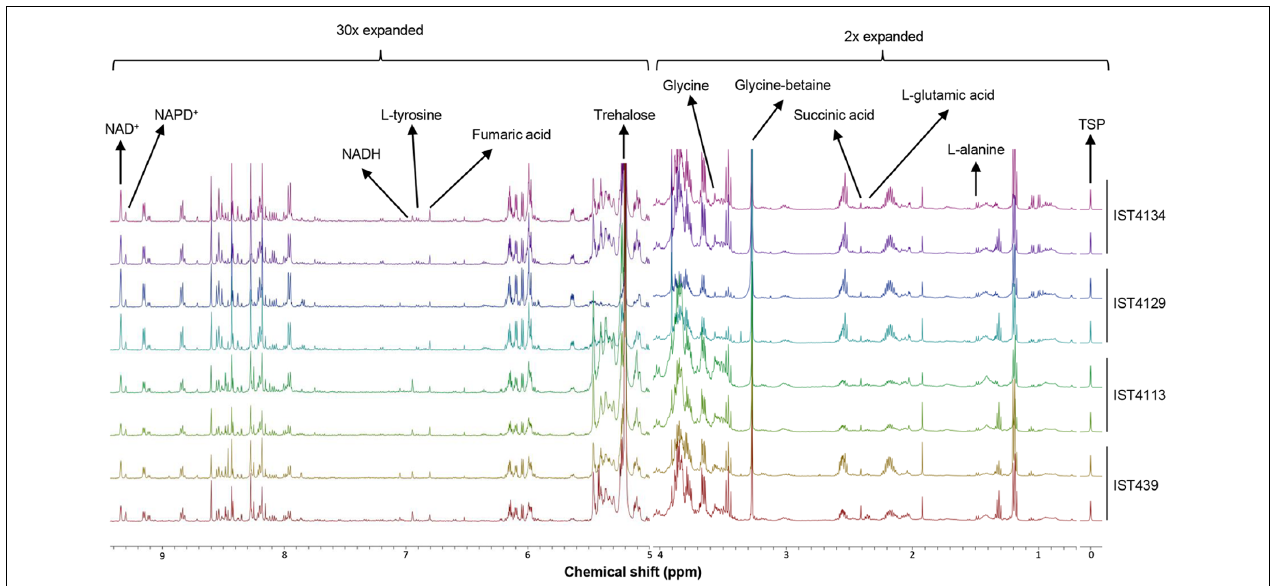
FIGURE 1 | Representative endo-metabolome profiles. High resolution 1 H NMR spectra from the endometabolomes of B. cenocepacia sequential clonal variants retrieved from a CF patient chronically colonized for 3.5 years. Spectra are representative of all the replicates obtained for each isolate and were normalized to the reference, TSP ( δ = 0.0